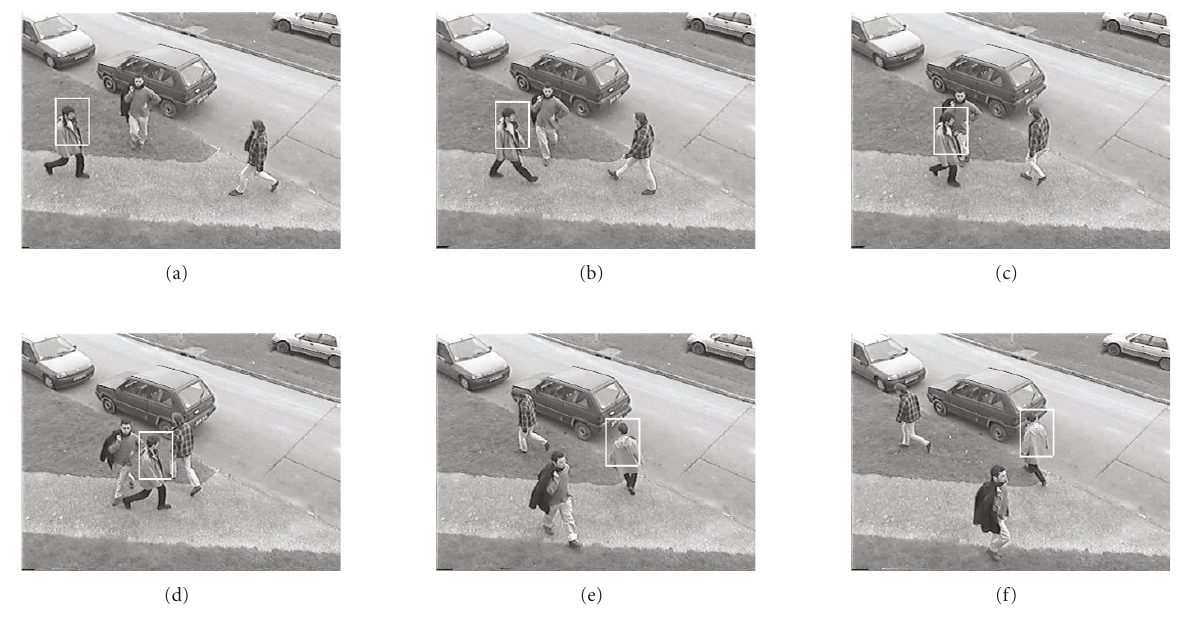
Figure 11: Tracking man 1 in video sequence given in Figure 6 at time t = 9,19,26,37,67,80.